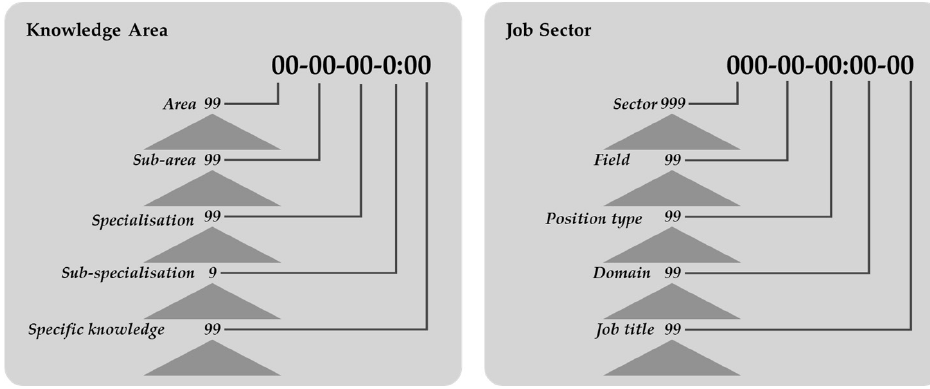
Figure 3. Hierarchical encodings of User Profiles.